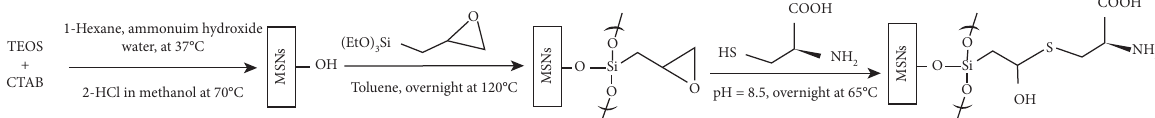
Figure 1: Illustration of the synthesis of mesoporous silica nanoparticles functionalised with cysteine